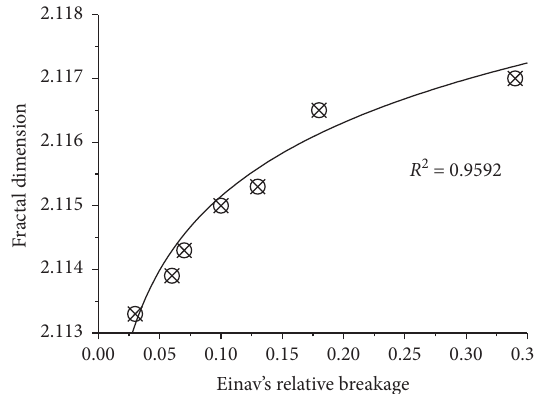
Figure 10: Relationship between Einav’s relative breakage and fractal dimension.